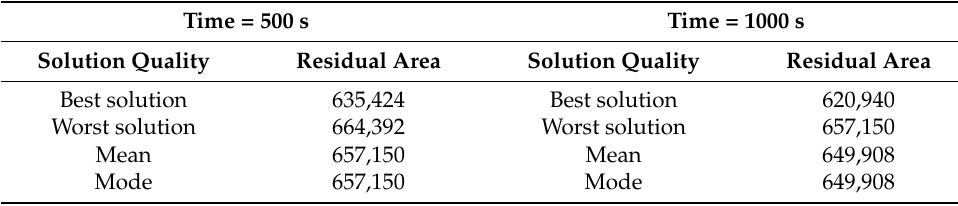
Table 5. ILS behavior with different execution times (residual area).